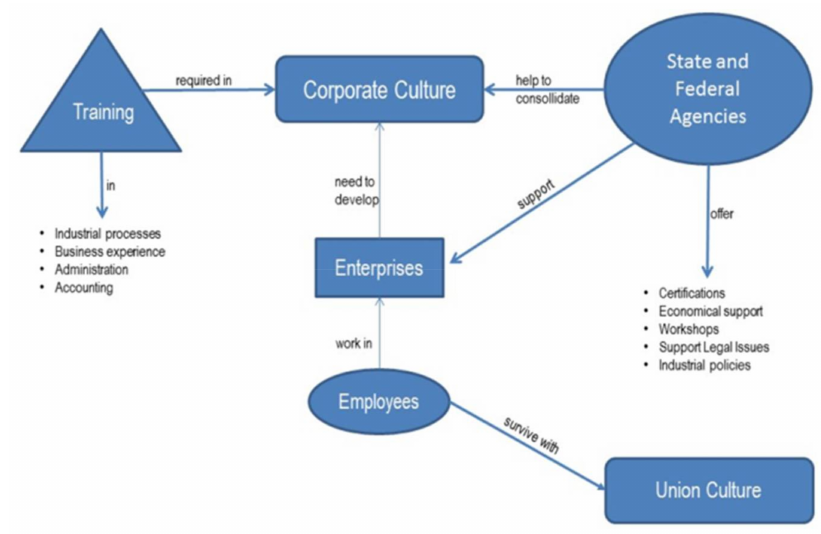
Figure 8. Primary version of the integrative model. Source: Author’s elaboration from information obtained in the focus group.